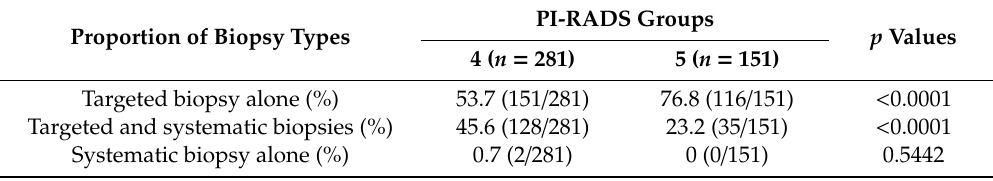
Table 2. Proportion of transrectal ultrasound-guided biopsies according to lesion visibility.